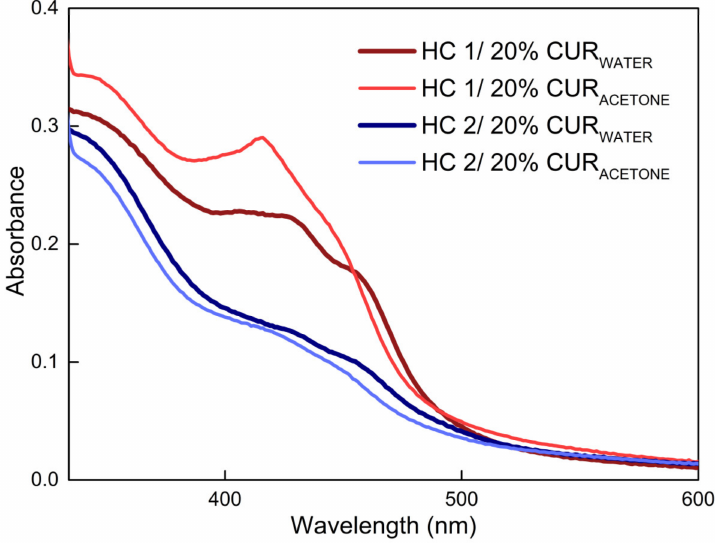
Figure 10. UV-Vis spectra of the CUR loaded PNPs upon dilution in acetone and water. (C HC = 1.67 × 10 − 4